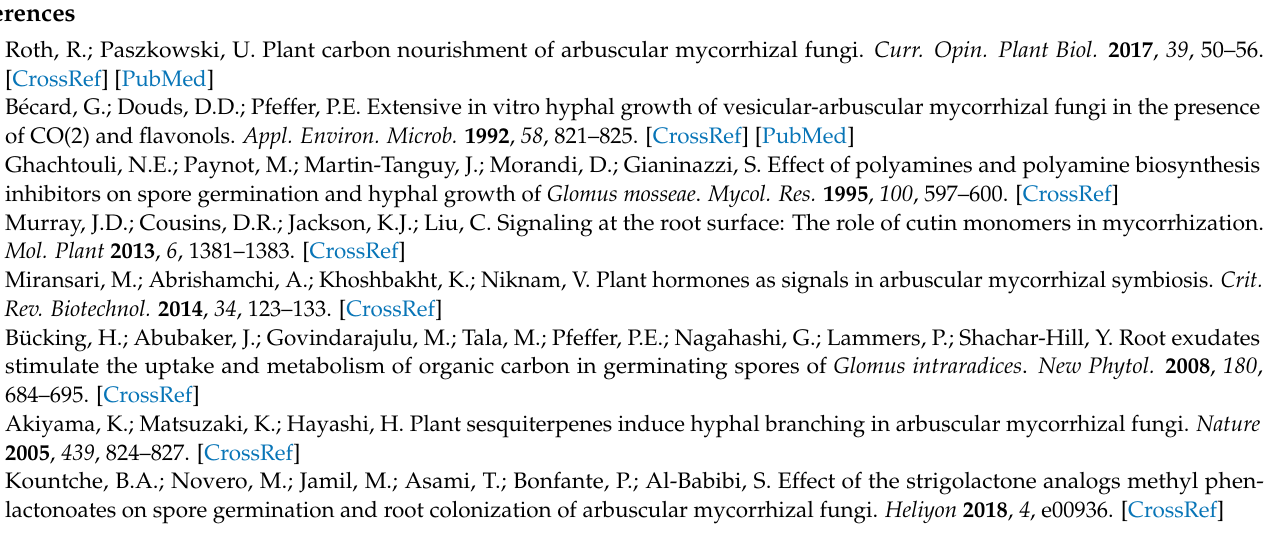
Table S1: The metabolic profiles of white clover roots grown under different phosphorus fertilization levels; Table S2: Differentially accumulated metabolites of white clover roots grown under different phosphorus fertilization